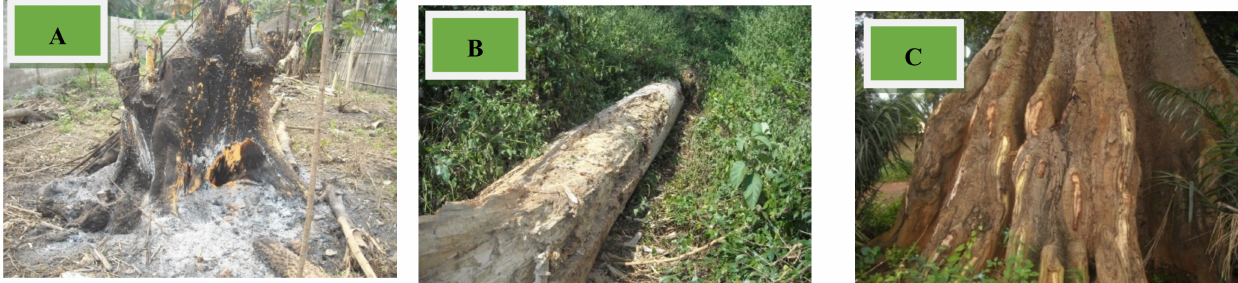
Figure 12. Threats to the conservation of LOTs (Photos: Atindehou, 2019). Photos: ( A ): LOT inciner- ated in Ketou (Age estimated at 150 years); ( B ): LOT felled in Ketou city (120 years, Dbh = 103 cm); and ( C ): Heavily debarked Ceiba pentandra (132 years, Dbh = 121cm) plant in Abomey